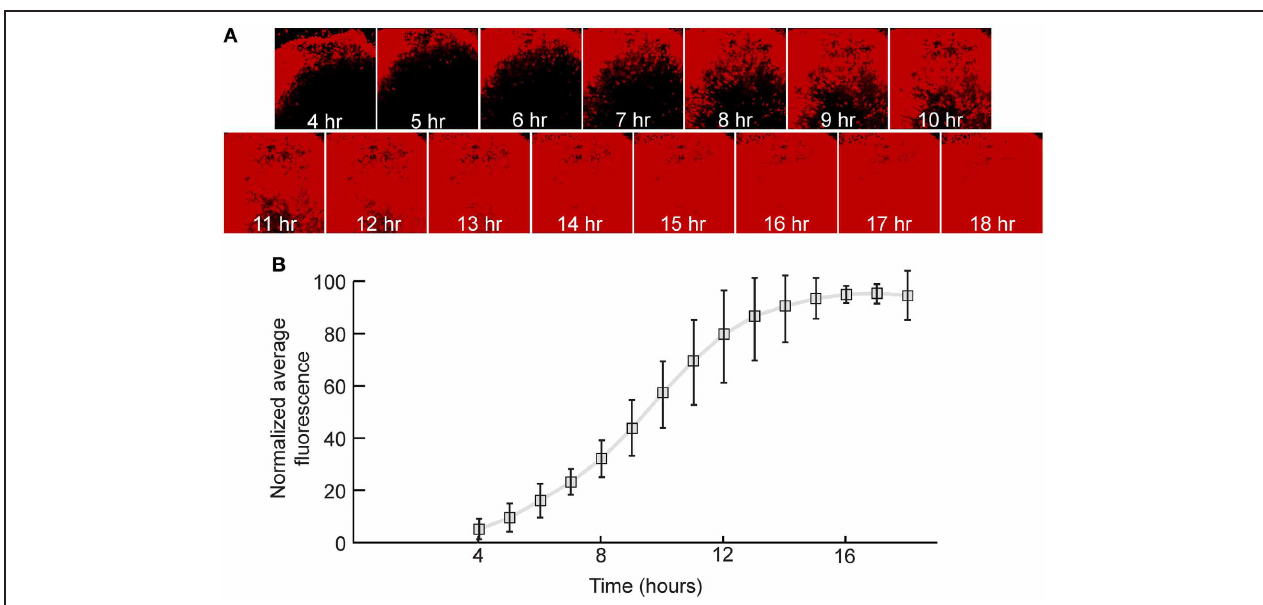
FIGURE 3 | Quantification of viral transgene expression over time. (A) After 7 days in vitro (DIV), hippocampal slice cultures were infected with rVSV (cid:2) G(RABV-G) expressing mCherry in the first genomic position. Sample